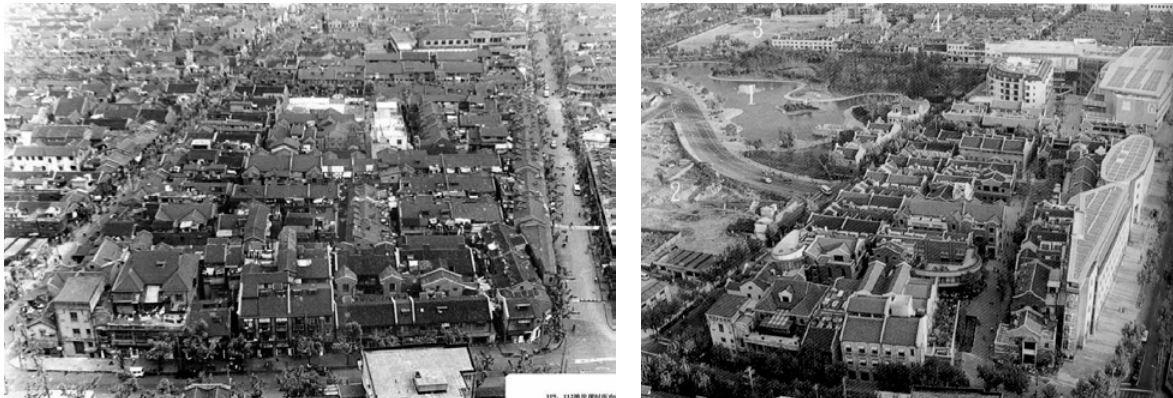
fig. 3. The area before renovation (left); XTD after renovation